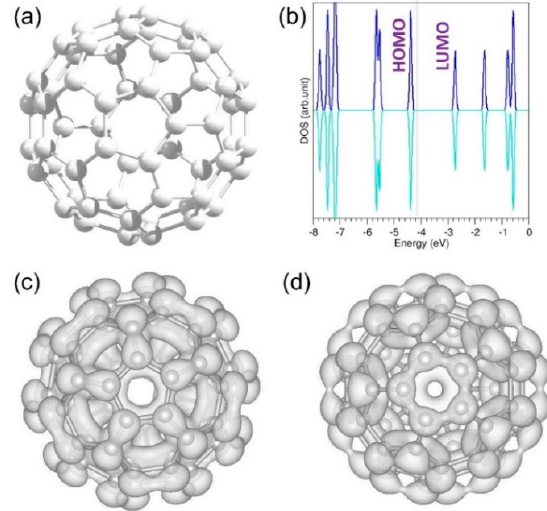
Figure 2. Relaxed structure ( a ), total density of state (DOS) ( b ), highest occupied molecular orbital (HOMO) ( c ), and lowest occupied molecular orbital (LUMO) ( d ) of a C 60 molecule.